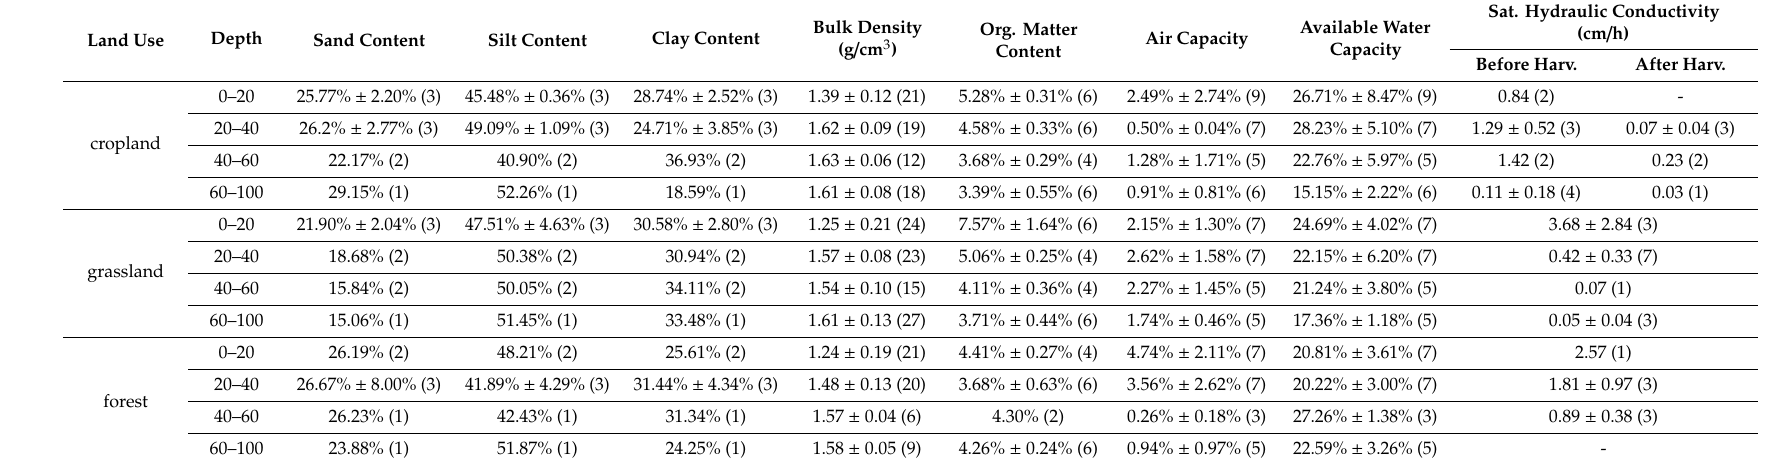
Table 2. Soil properties of the measurement site divided into land use types and depth categories. Given values are the mean, the standard deviation and the number of analyzed probes (in